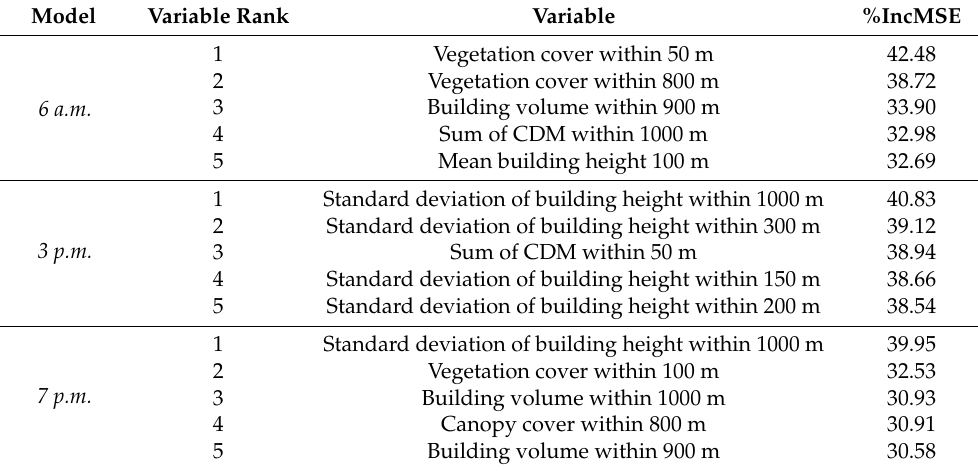
Table 3. The five most important landscape features using the RF model (determined by the %IncMSE) by time